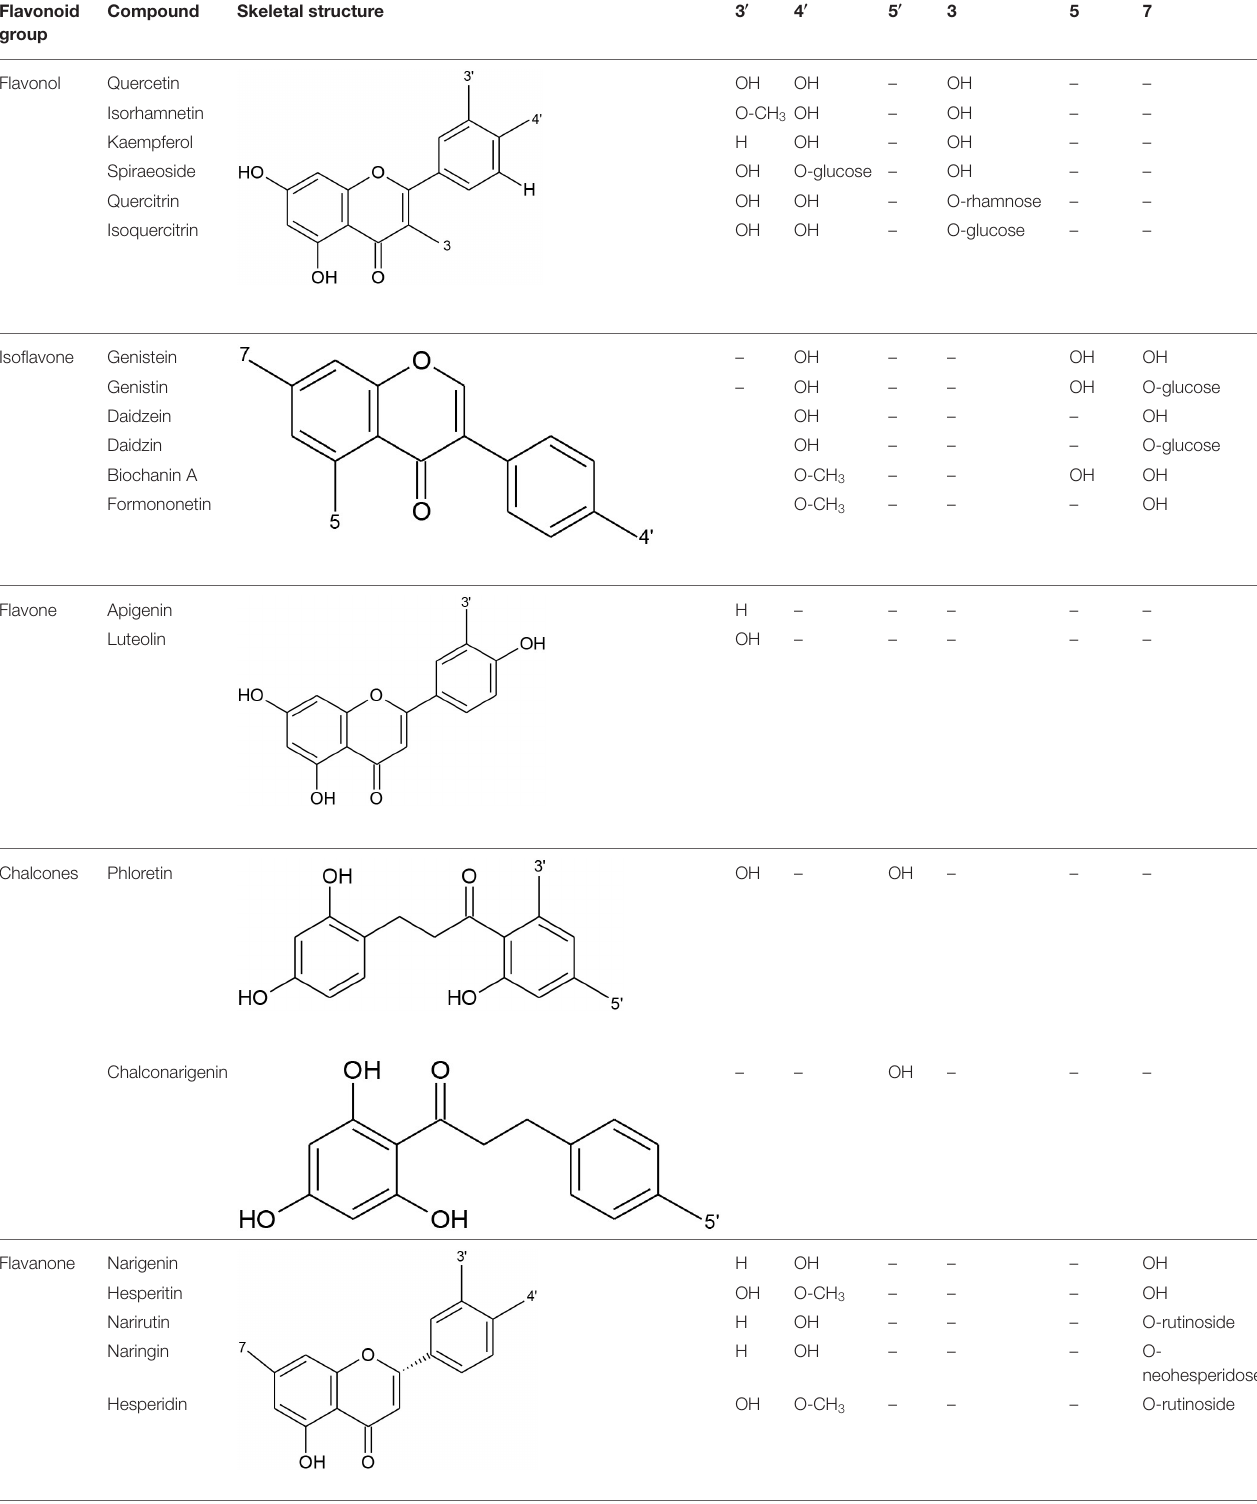
TABLE 1 | Classification of flavonoids and their classes according to their skeletal structure. Flavonoid group